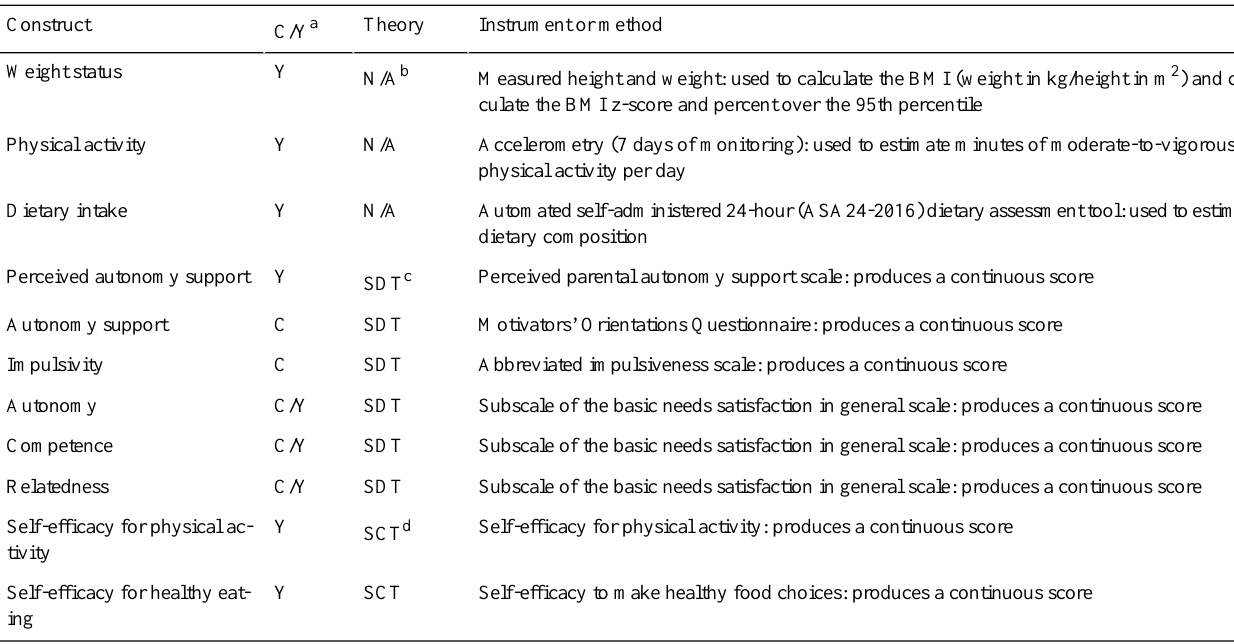
Table 2. Intervention-targeted constructs to be measured, participant providing data, theory, and instrument or method used.